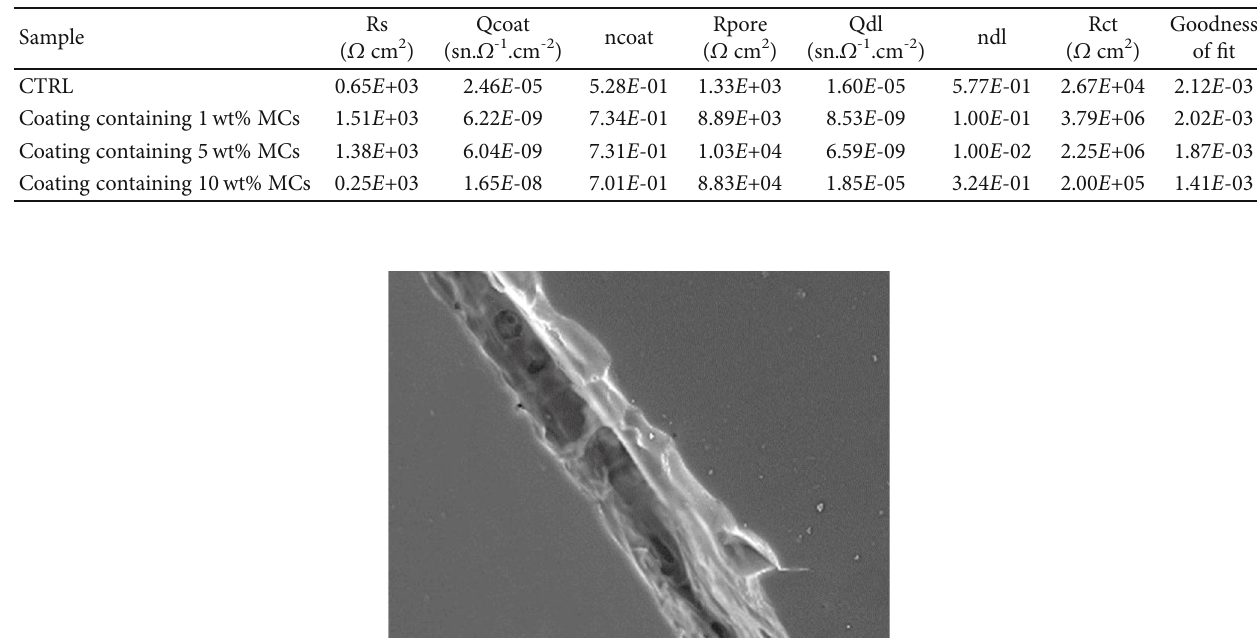
Table 6: The EIS parameters for the scratched control and MC containing coatings after being immersed in 3.5% NaCl solution for 14 days (0.785 cm 2 circular contact area).